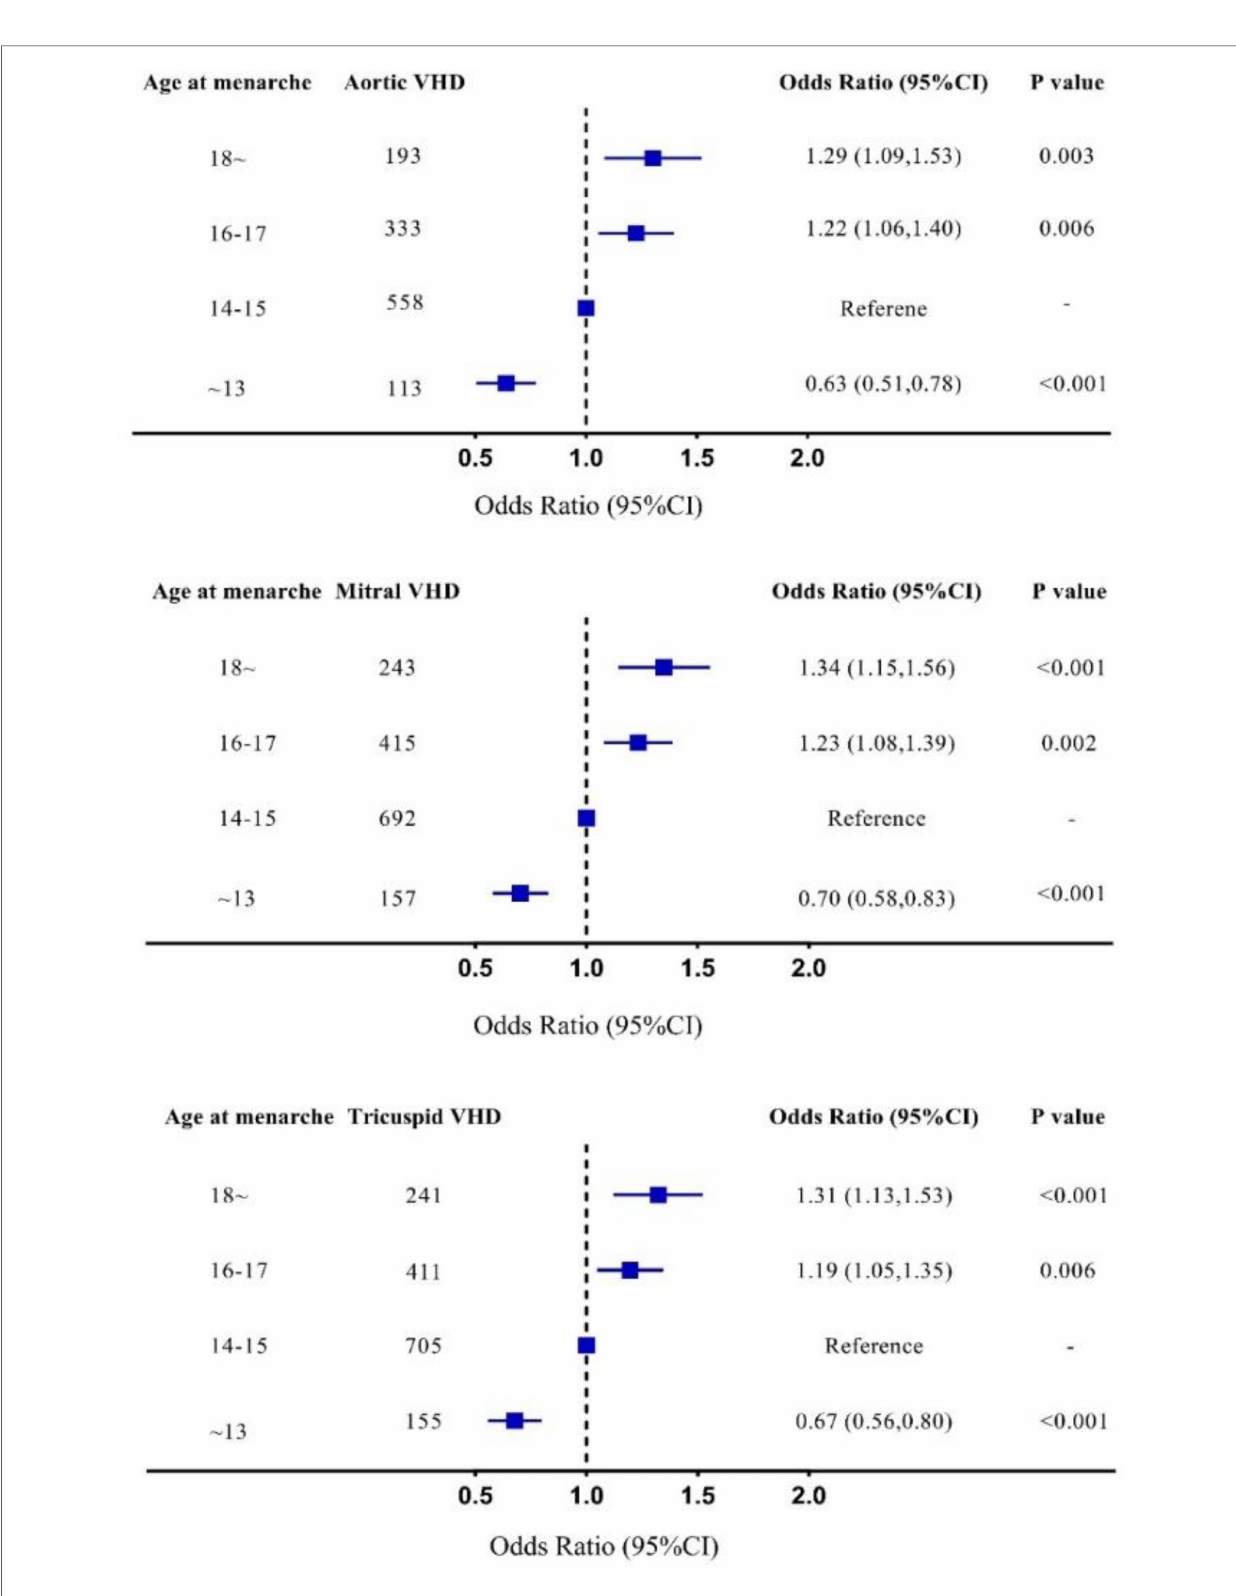
FIGURE 5 Subgroup analysis in different valves, adjusted for age, smoking status, systolic blood pressure, antihypertensive agents, diabetes mellitus, body mass index, high density lipoprotein cholesterol, and total cholesterol. 95% CI, 95% con fi dence interval; Mitral VHD, valvular heart disease presents as mitral valve disease; Aortic VHD, valvular heart disease presents as aortic valve disease; Tricuspid VHD, valvular heart disease presents as tricuspid valve